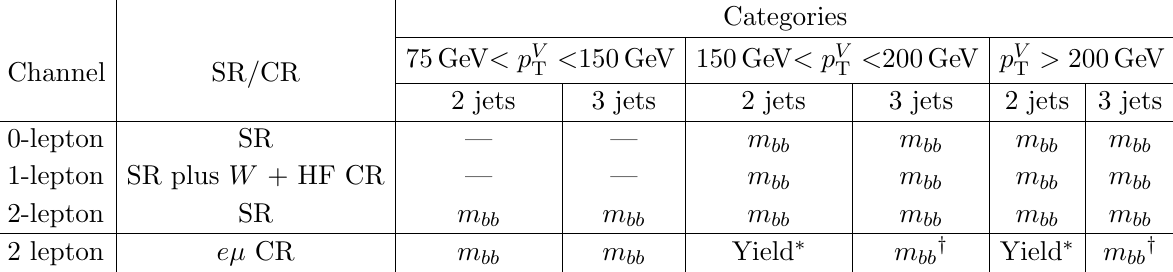
Table 12 . The distributions used in the global likelihood (cid:12)t for the dijet-mass analysis, for the signal regions (SR) and control regions (CR), for all the categories in each channel. The two regions marked with (cid:3) ( y ) are merged into a single region, to reduce statistical